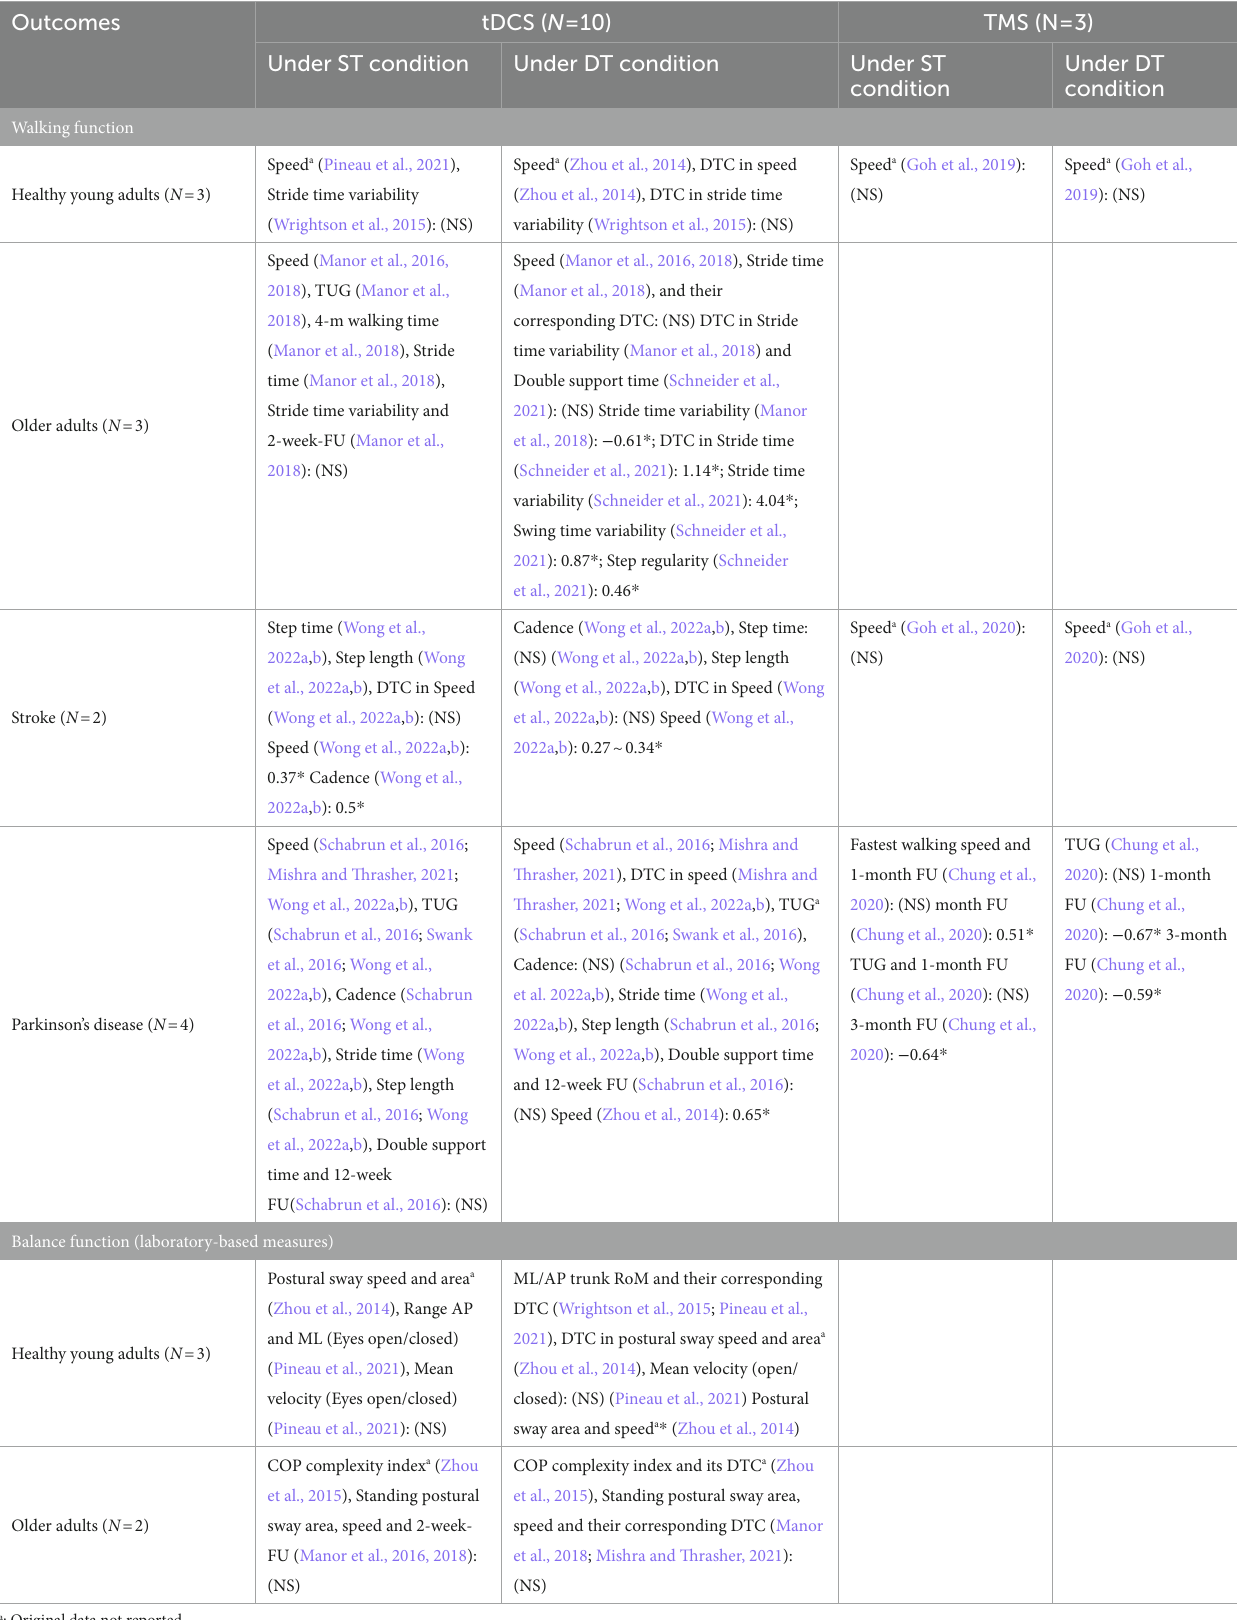
TABLE 3 NIBS: Effects on mobility outcomes.